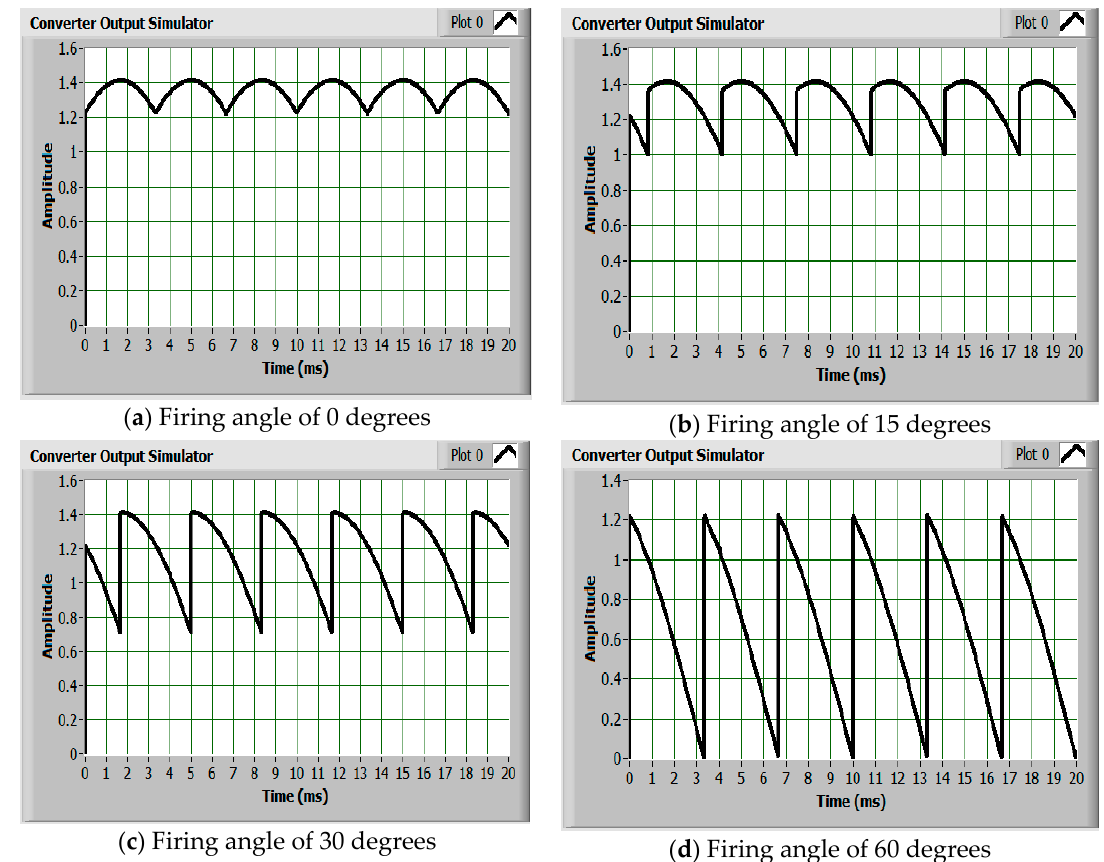
Figure 5. Output voltages of the converter simulator for firing angles of ( a ) 0°, ( b ) 15°, ( c ) 30°, and ( d ) 60°.